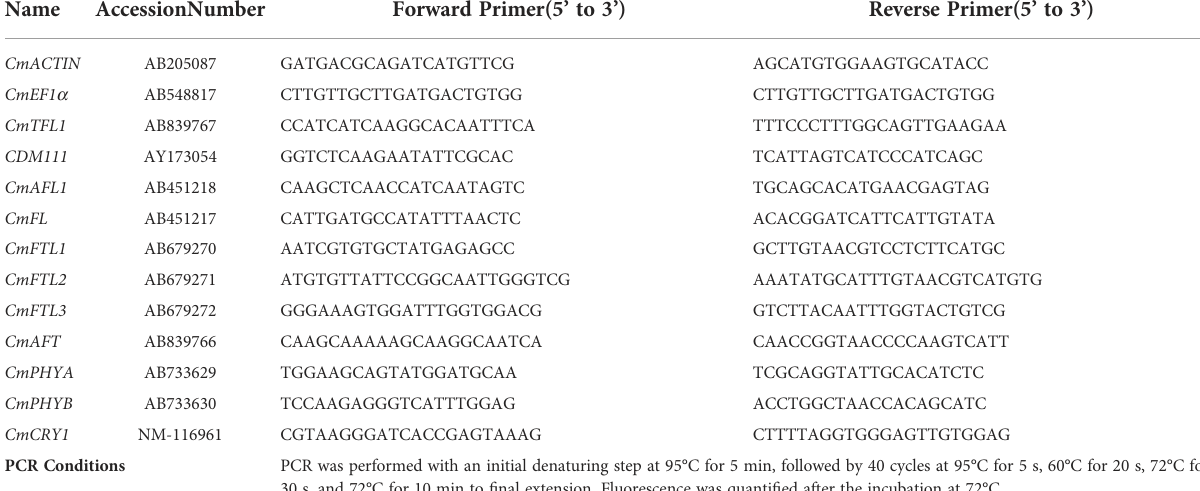
TABLE 1 The primers and PCR conditions used to quantify the gene expression